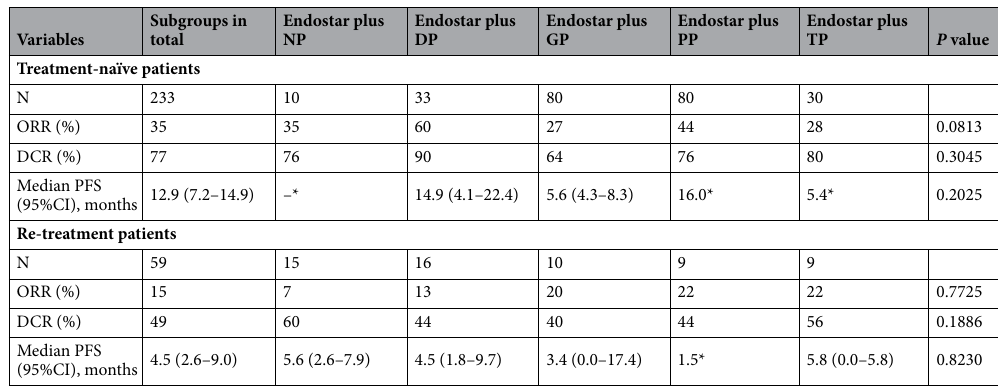
Table 4. The ORRs, DCRs and PFSs of Endostar plus different chemotherapy in treatment-naïve patients and in re-treatment patients. * Too few people to estimate PFS and confidence